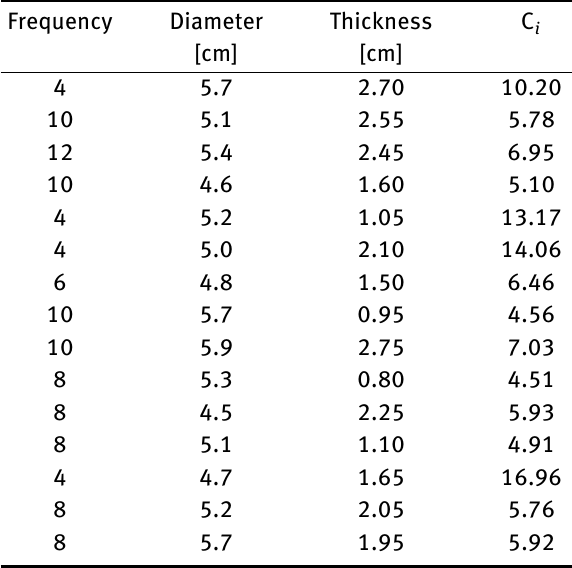
Table 6: Sum of equally-weighted row minimum standardizations Frequency